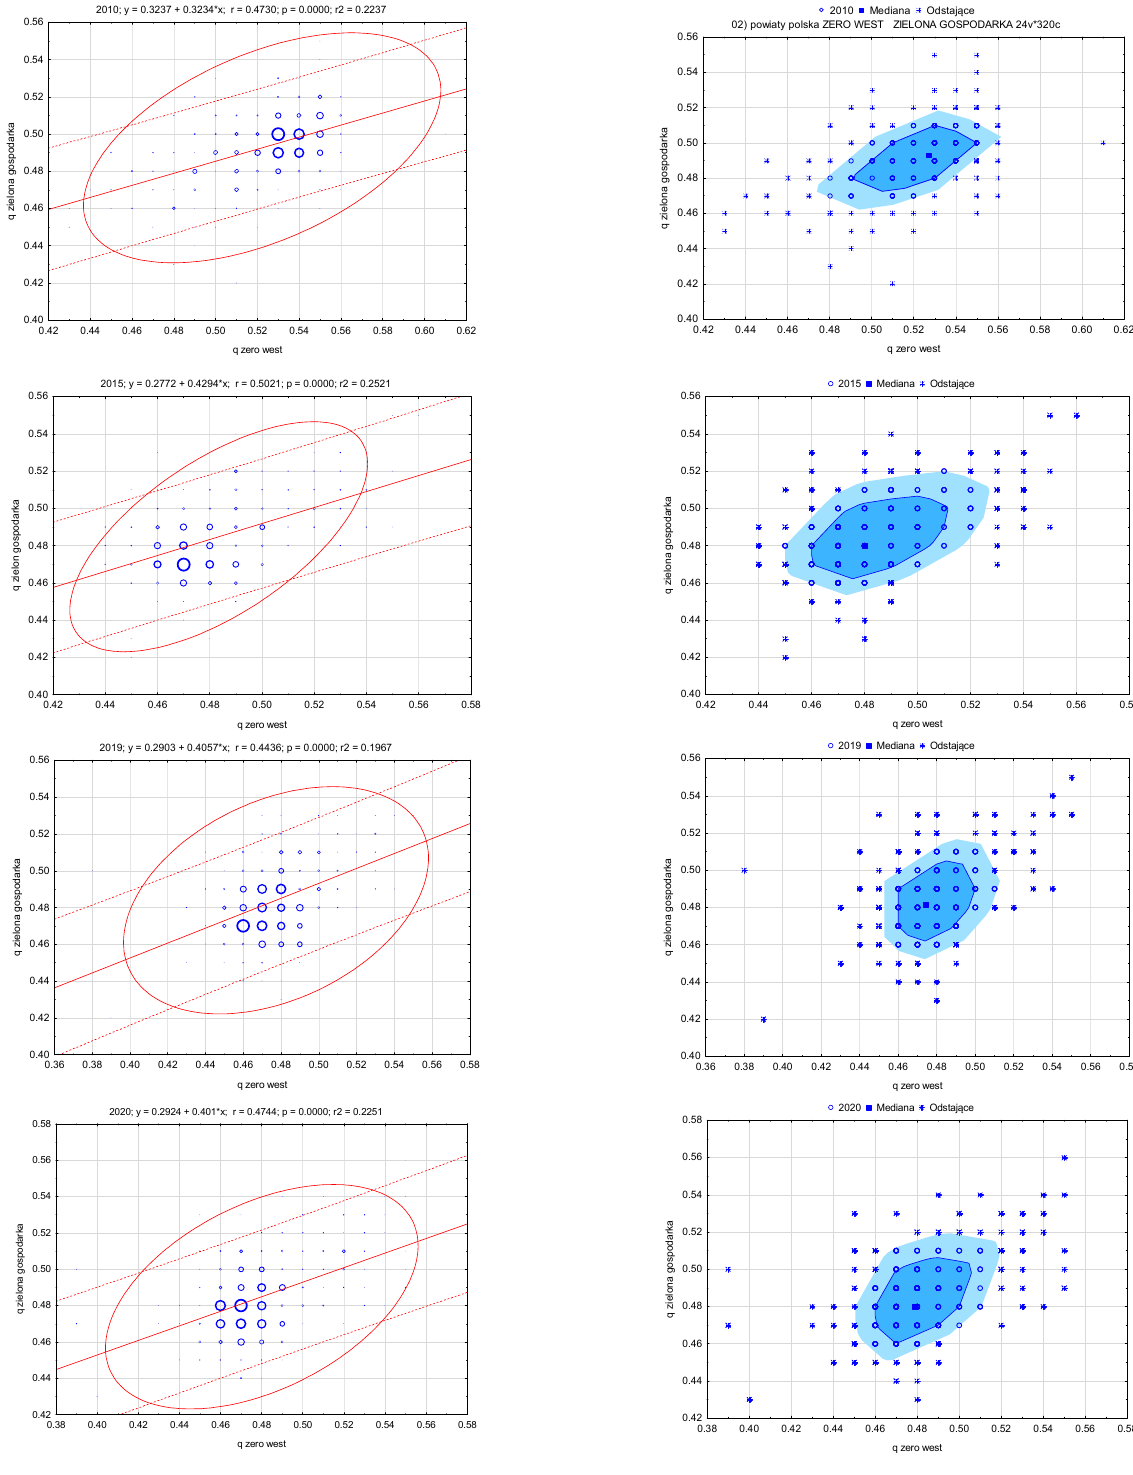
Figure 6. Relation of the synthetic measure, waste management and green economy in districts in Poland (in 2010, 2015, 2019, and 2020). Source: own study based on the BDL CSO data. As Figure 7 shows, the summary metric of neighborhood waste management in 2020 versus 2020/2010 was subject to divergence (the correlation coefficient was 0.617), in the case of the green economy metric—0.550. In the case of the ratio between the measure in 2020 and the 2020/2019 ratio, it was, respectively, 0.469 (waste management) and 0.285 (green economy).